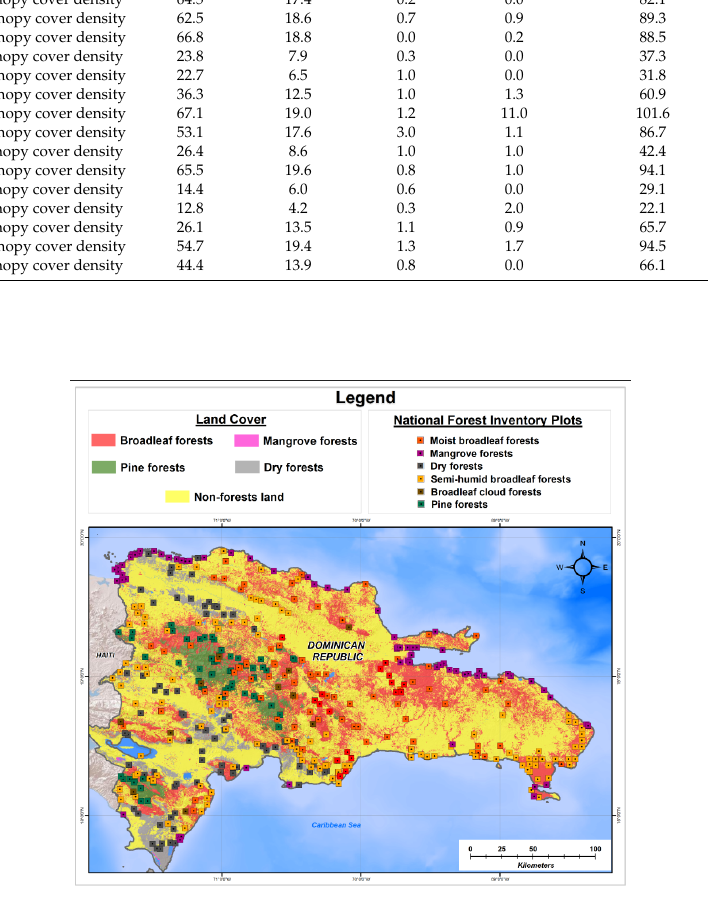
Figure A1. Reference map of the National Forest Inventory (NFI) collected by the Ministry of the Environment and Natural Resources (MARN) of the Dominican Republic.